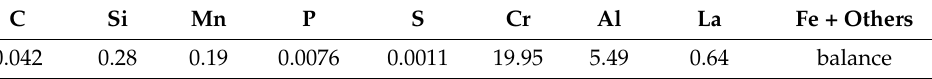
Table 1. Chemical composition of the Fe-Cr-Al-La alloy ingot (wt.%).